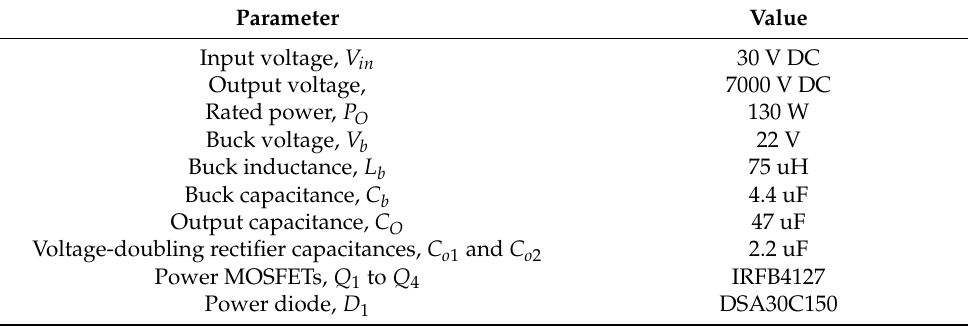
Table 1. Parameters of the